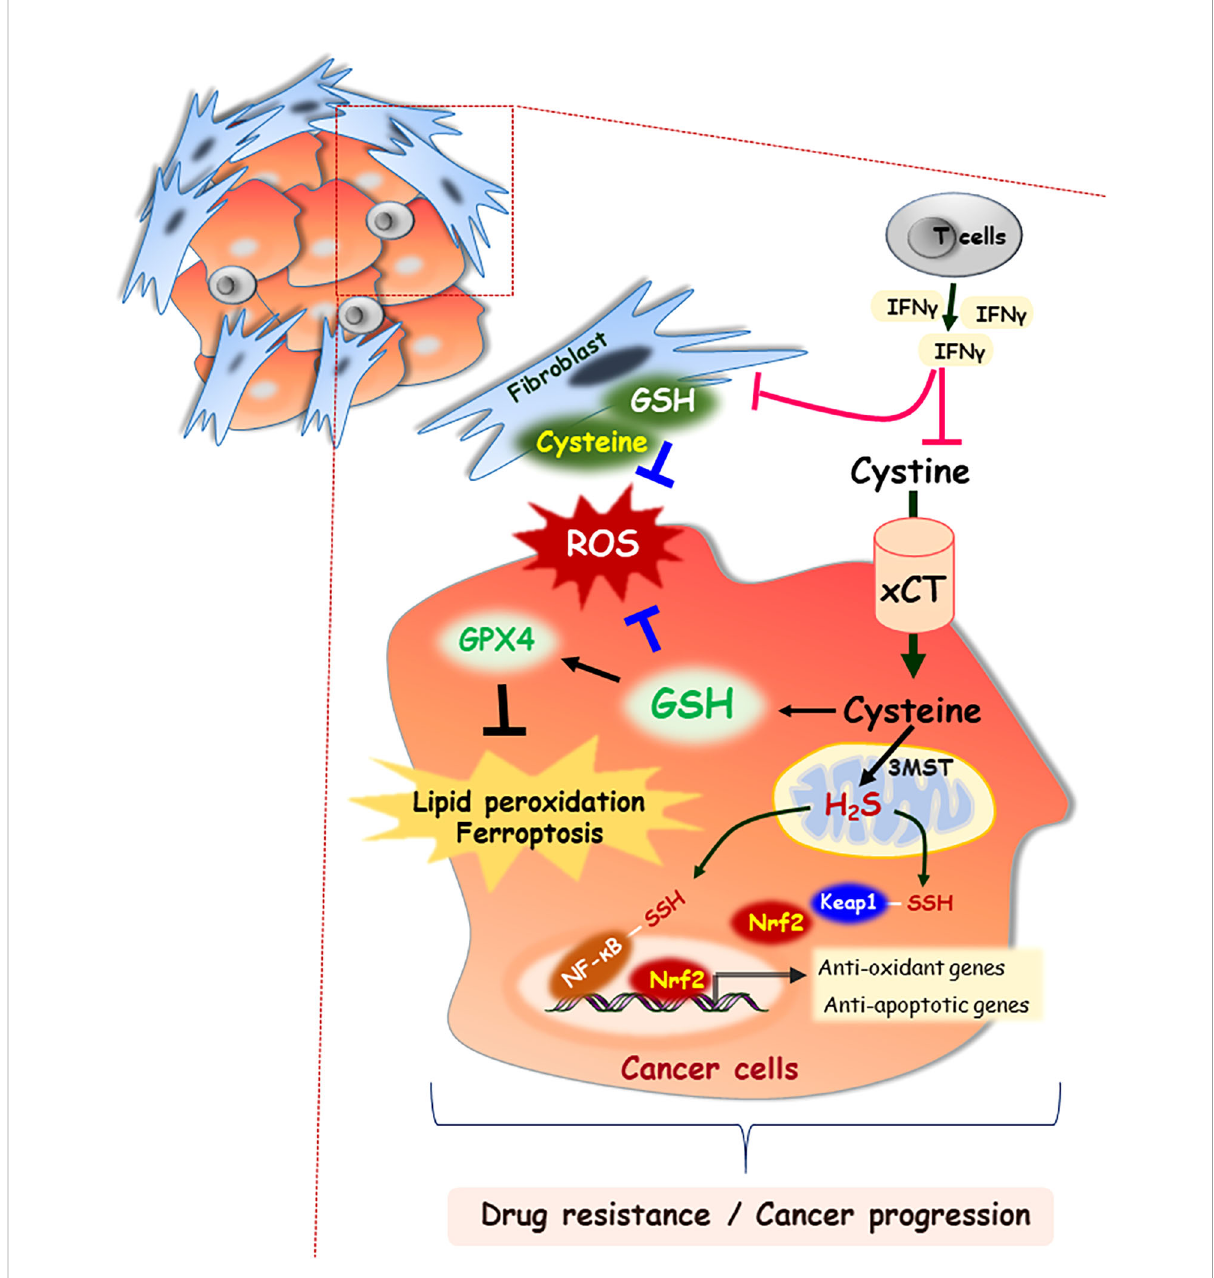
FIGURE 2 Cysteine as an important building block for cell-cell communication in tumor microenvironment. In the extracellular space, cysteine mainly exists as the oxidized dimer form, cystine. Both forms of cysteine and cystine can be imported into cells through speci fi c transporters, xCT. GSH is synthesized from cysteine, which functions in concert to detoxify ROS. GSH acts as an essential cofactor for GPX4 enzymatic activity, which results in blocking lipid peroxidation and ferroptosis. Stromal fi broblast-derived cysteine and GSH also scavenge the ROS in tumor microenvironment, which contribute to cancer progression. However, IFN- g derived from CD8 + T cells attenuates drug resistance through downregulation of xCT. In addition, 3MST resident in mitochondria generates H 2 S, and then it induces the NF- k B activation by persul fi dation of its subunit or nuclear localization of Nrf2 via persul fi dation of